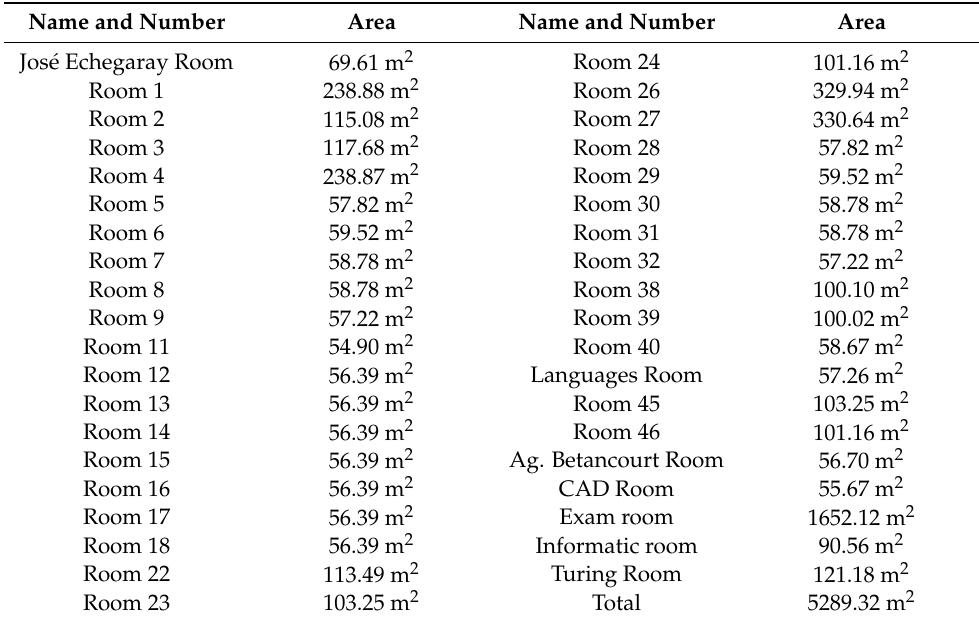
Table 1. Total areas of teaching rooms.